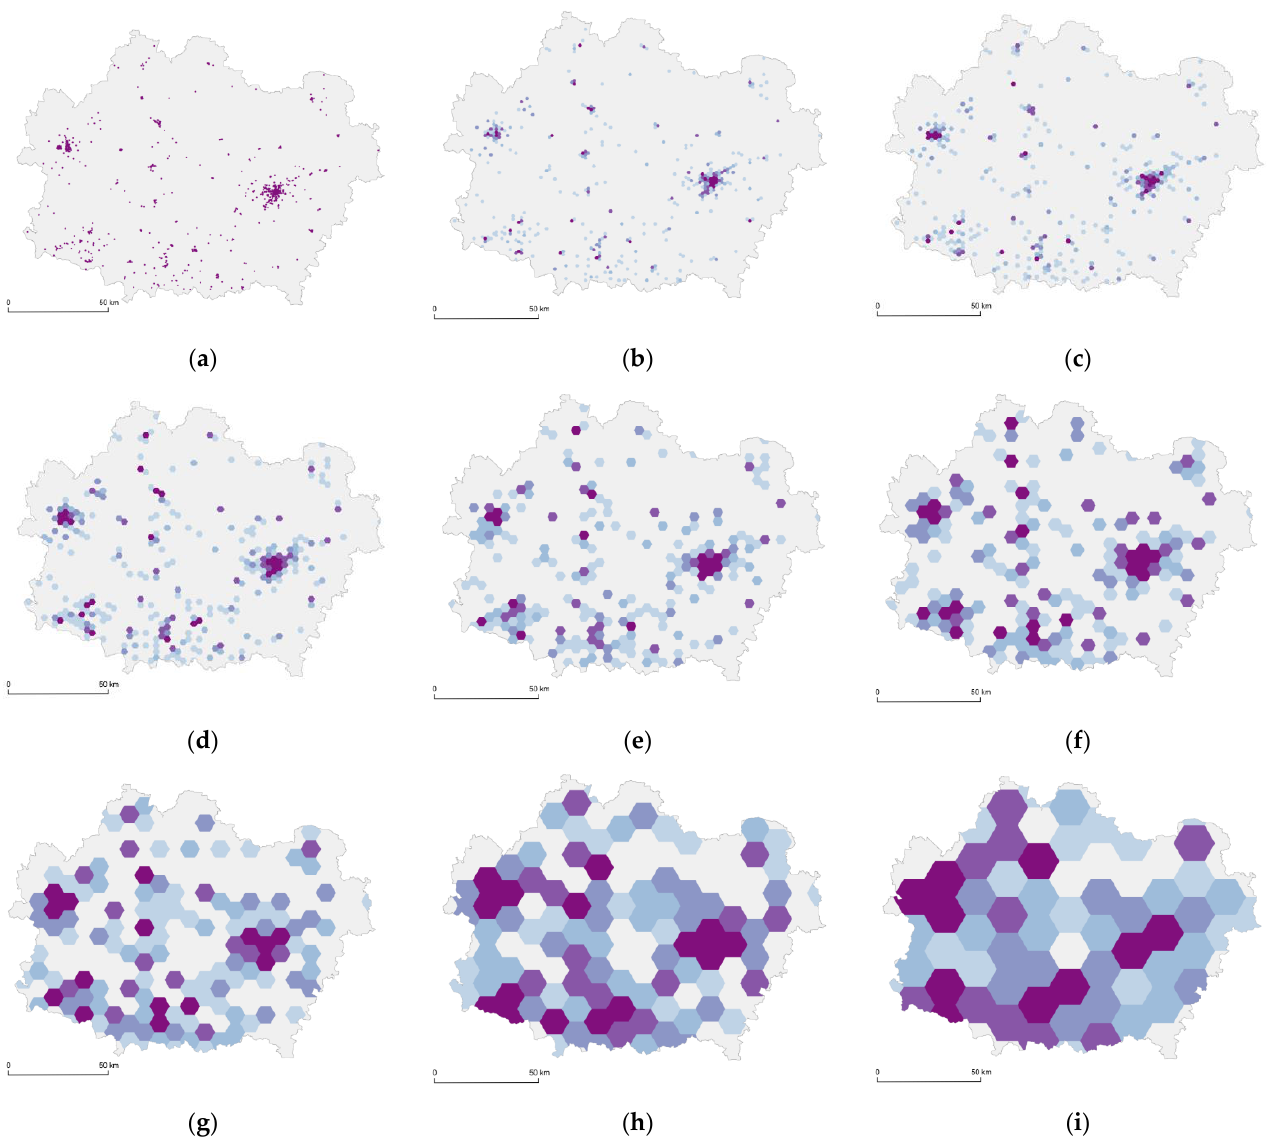
Figure 2. The maps used in the study with their corresponding applied EUSs. The maps used in this table are also presented in Supplementary Materials in a larger scale (Figure S1). ( a ) Symbol map, ( b ) A. 26 pixels, ( c ) C. 52 pixels, ( d ) E. 104 pixels, ( e ) H. 208 pixels, ( f ) B. 416 pixels, ( g ) G. 832 pixels, ( h ) F. 1664 pixels, ( i ) D. 3328 pixels.